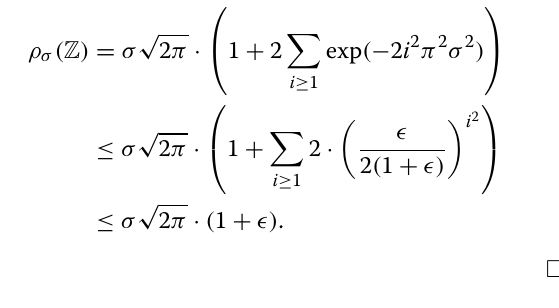
Algorithm 4 can sample from the Gaussian distri- butions over the integers while hiding the standard deviation, center, and output. It can be used as the fundamental operation modular in the lattice-based cryptography library. We applied it to PALISADE and obtained a more secure and efficient implementation of the MP trapdoor sampler. We can utilize the constant- time implementation of the Knuth-Yao sampler (Kar- performances of our implementations further. Besides,